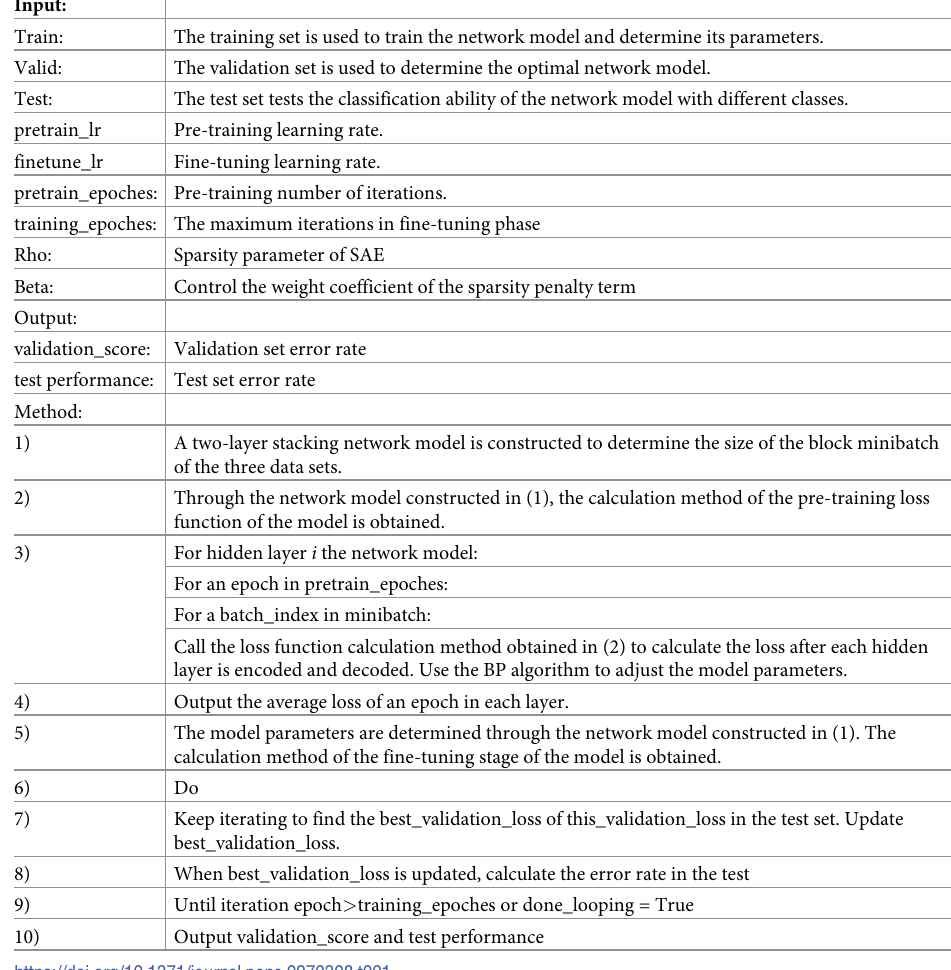
Table 1. Algorithm flow